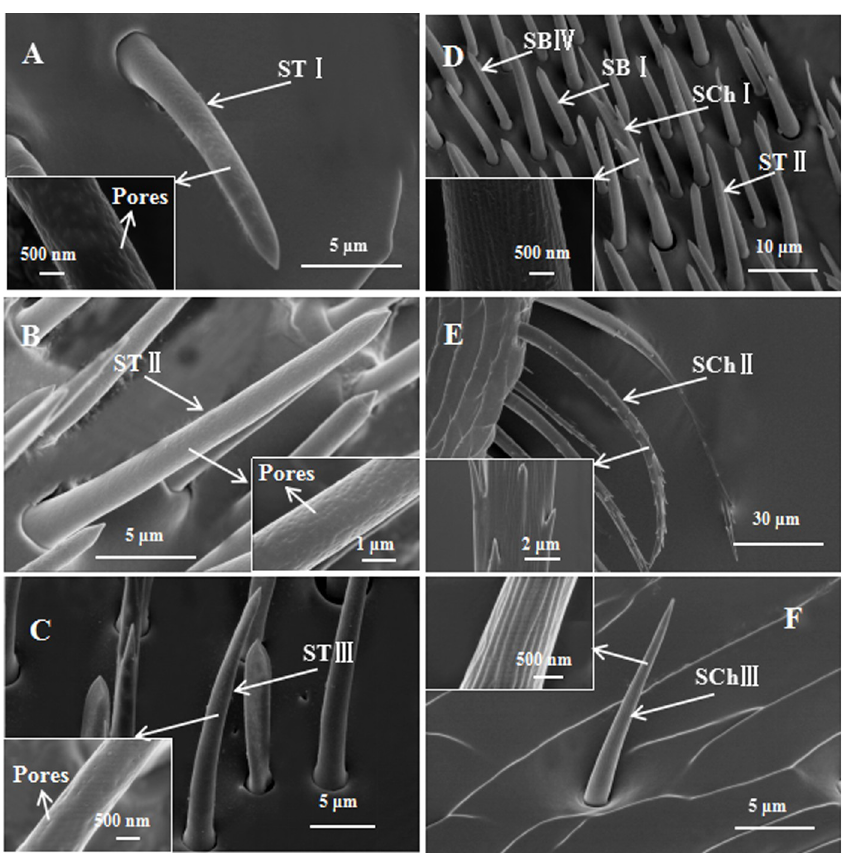
Fig 3. Scanning electron micrographs of sensilla external cuticular structures on Euplatypus parallelu antennae. A: STI. Inset: The high magnification picture of STI. B: STII. Inset: The high magnification picture of STII. C: STIII. Inset: The high magnification picture of STIII. D: SChI, SBI, SBIV, STII. Inset: The high magnification picture of SChI. E: SChII. Inset: The high magnification picture of SChII. F: SChIII. Inset: The high magnification picture of SChIII.